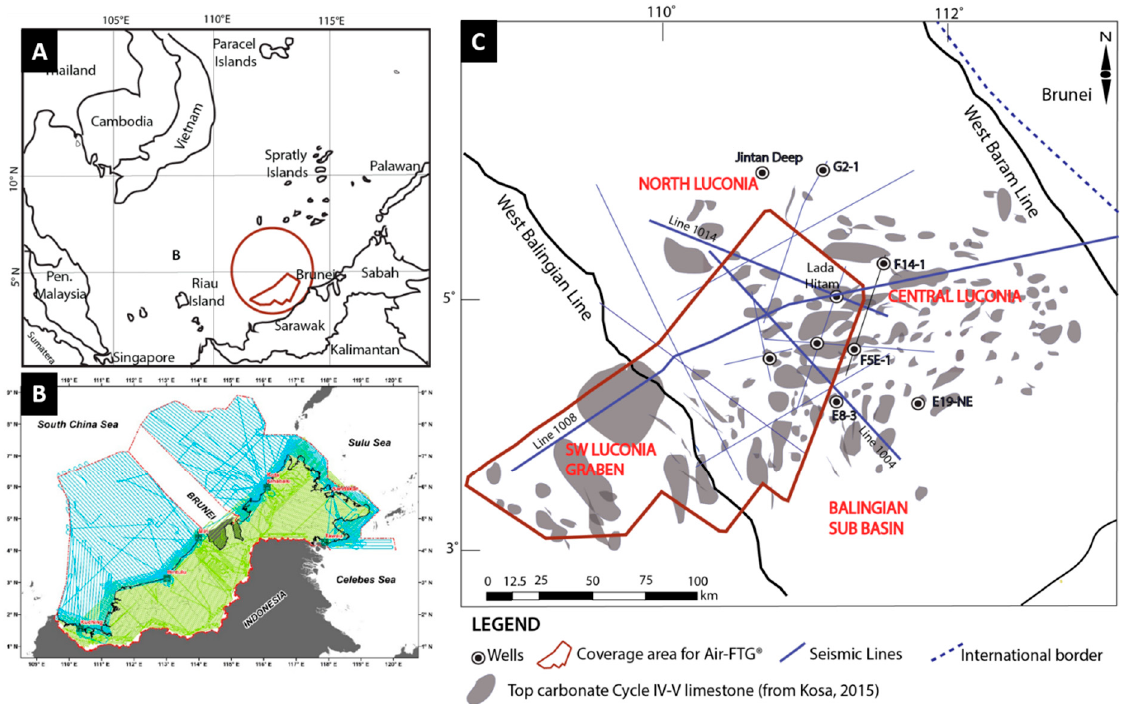
Figure 1. ( A ) Locality map showing the offshore Sarawak and coverage of the Air-FTG ® survey. ( B ) Airborne-gravity survey under MyGeoid Project by the government of Malaysia (H. Jamil et al., 2017). ( C ) Survey area for Air-FTG ® conducted by Bell Geospace and utilized in this study. Top carbonate map for Cycle IV-V limestone is overlaid with the survey area, the seismic profiles and exploration wells. Only three regional seismic lines are presented in this paper (labelled as Line 1014, 1004 and 1008). All datasets presented in ( C ) are courtesy of Malaysian Petroleum Management (MPM), PETRONAS.